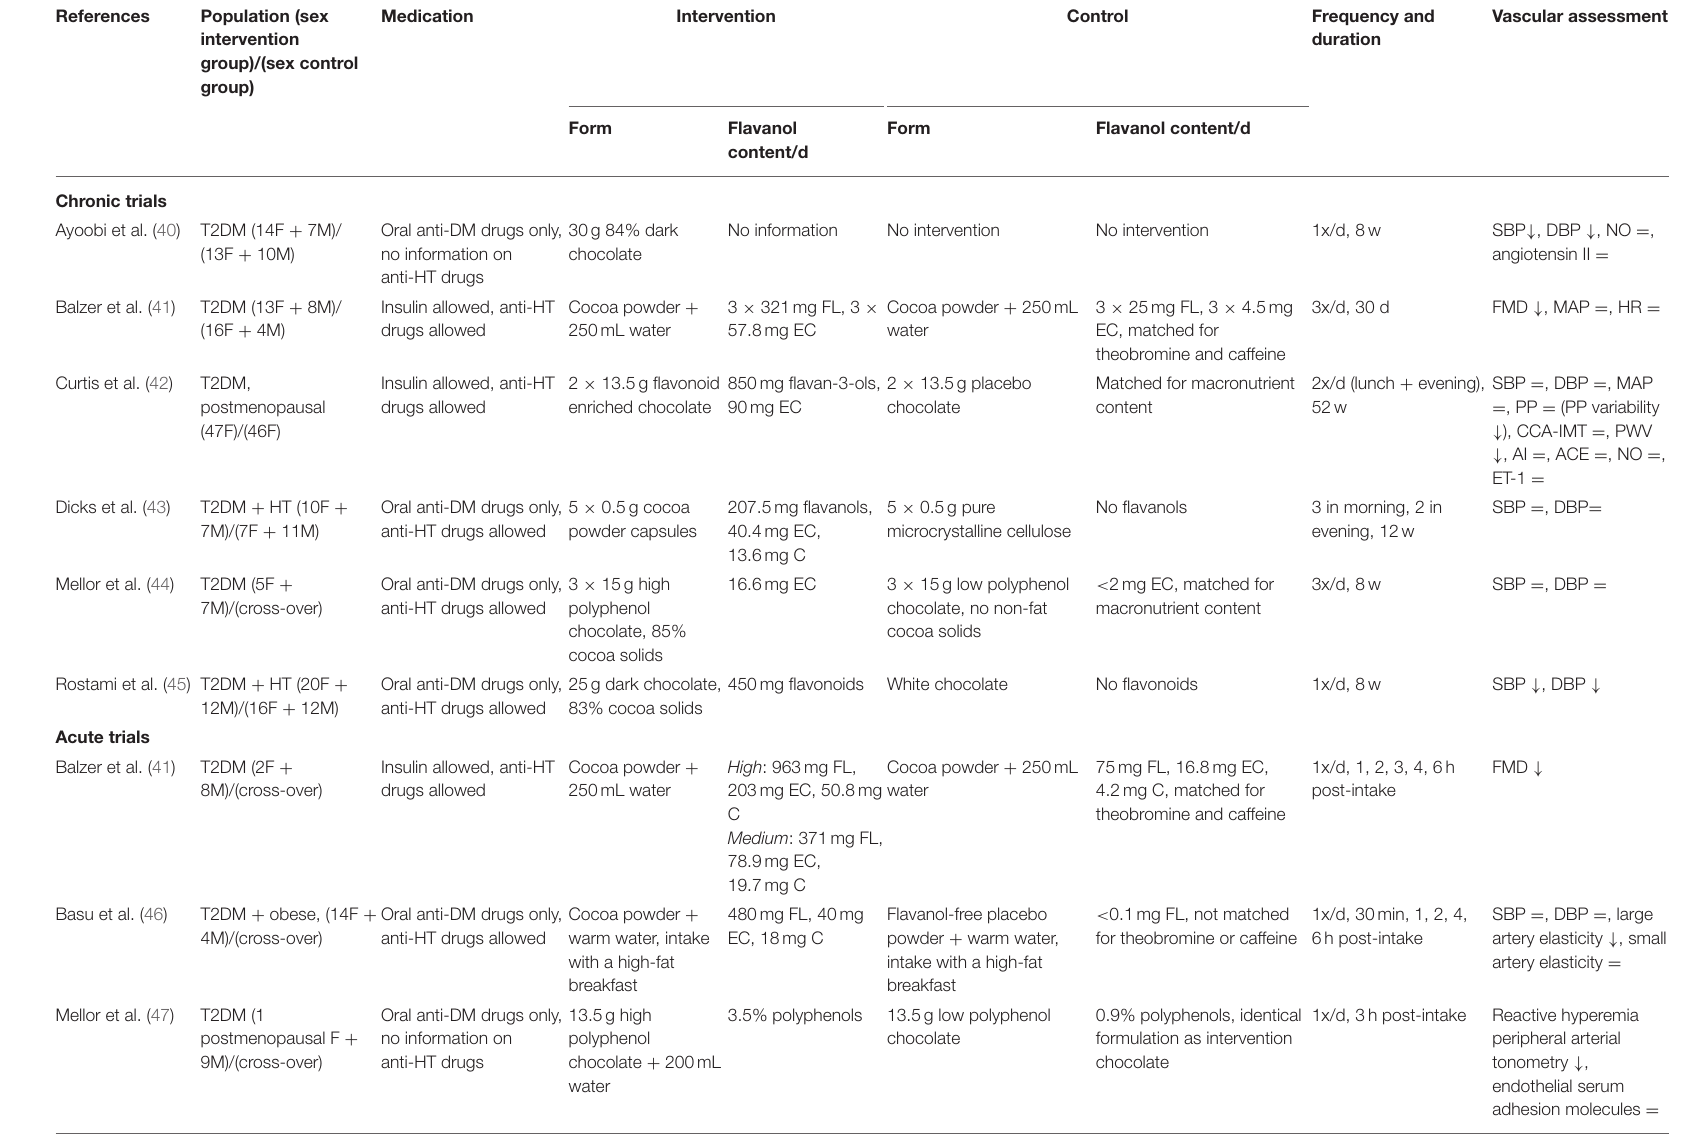
TABLE 1 | Characteristics of chronic and acute trials examining the effect of cocoa flavanols in patients with type 2